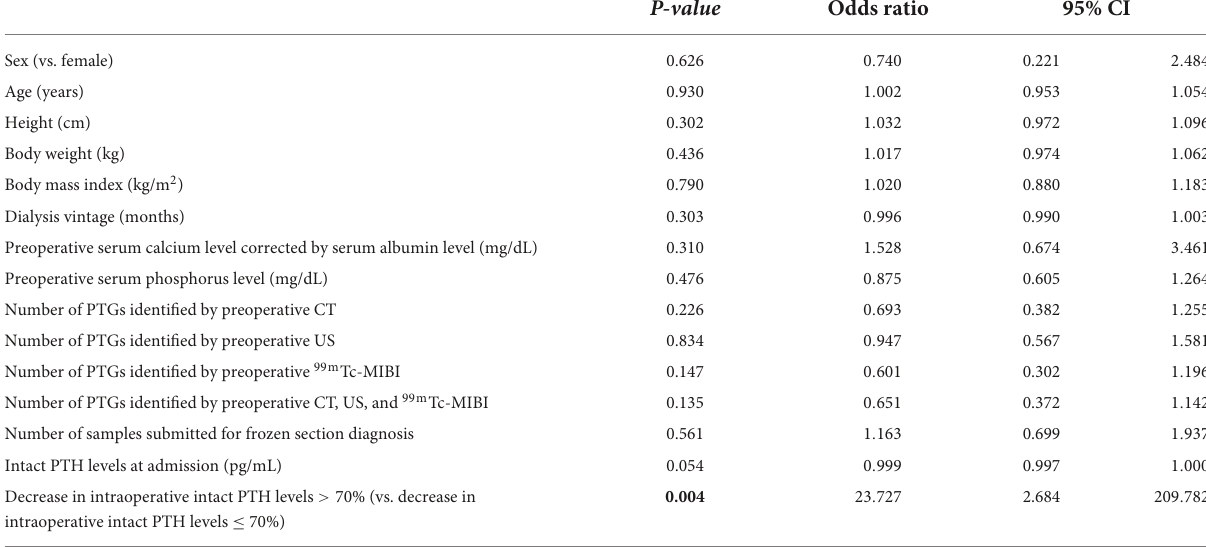
P-value Odds ratio 95% CI